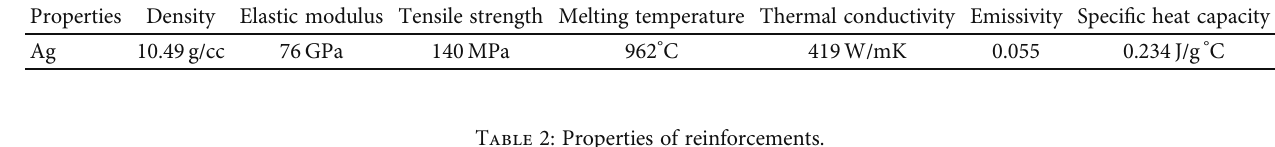
Table 1: Properties of silver matrix.